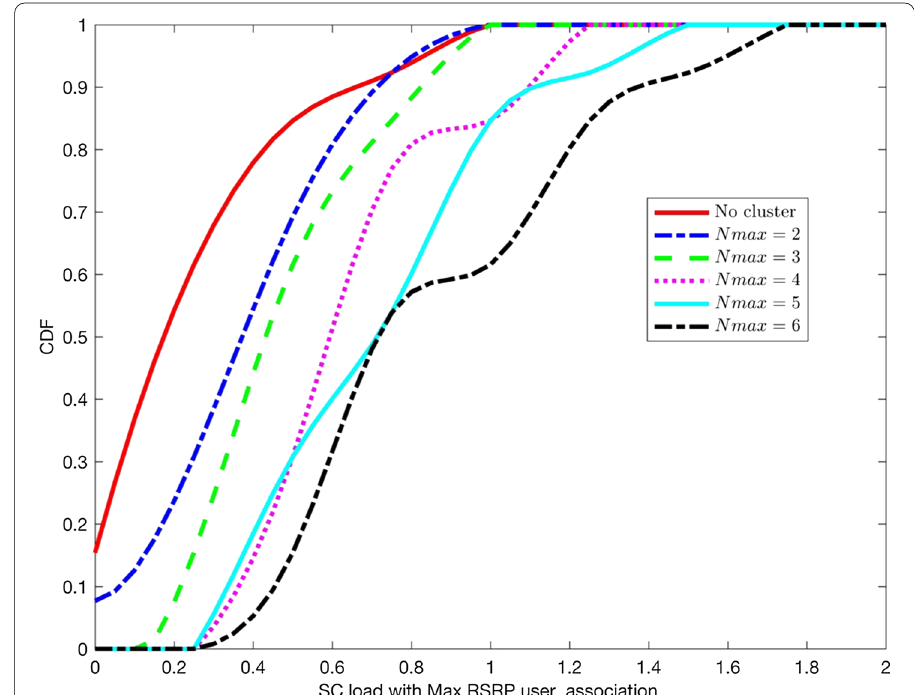
Fig. 4 SC load of Max RSRP user association with 350 UE/km 3 and 50 SBS/km 2